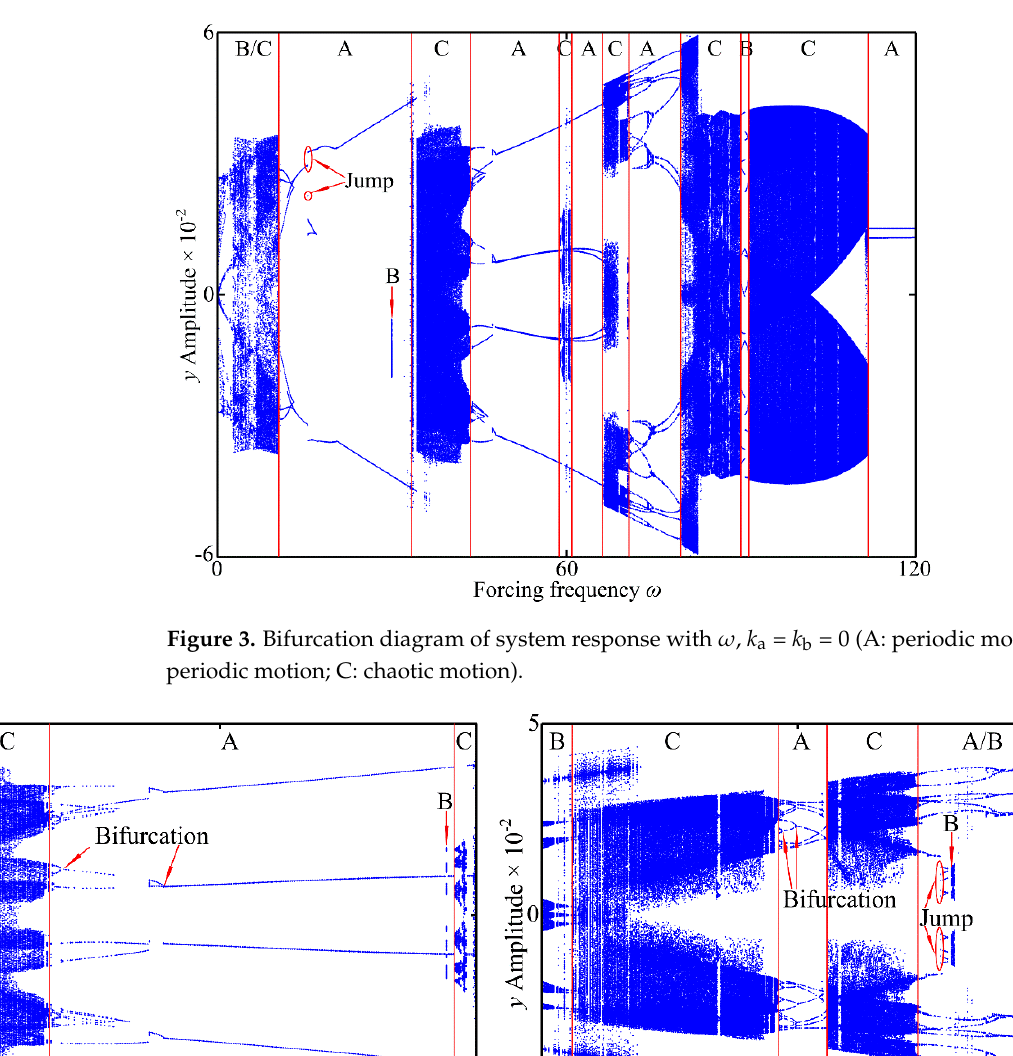
Figure 3. Bifurcation diagram of system response with ω , k a = k b = 0 (A: periodic motion; B: quasi- periodic motion; C: chaotic motion).